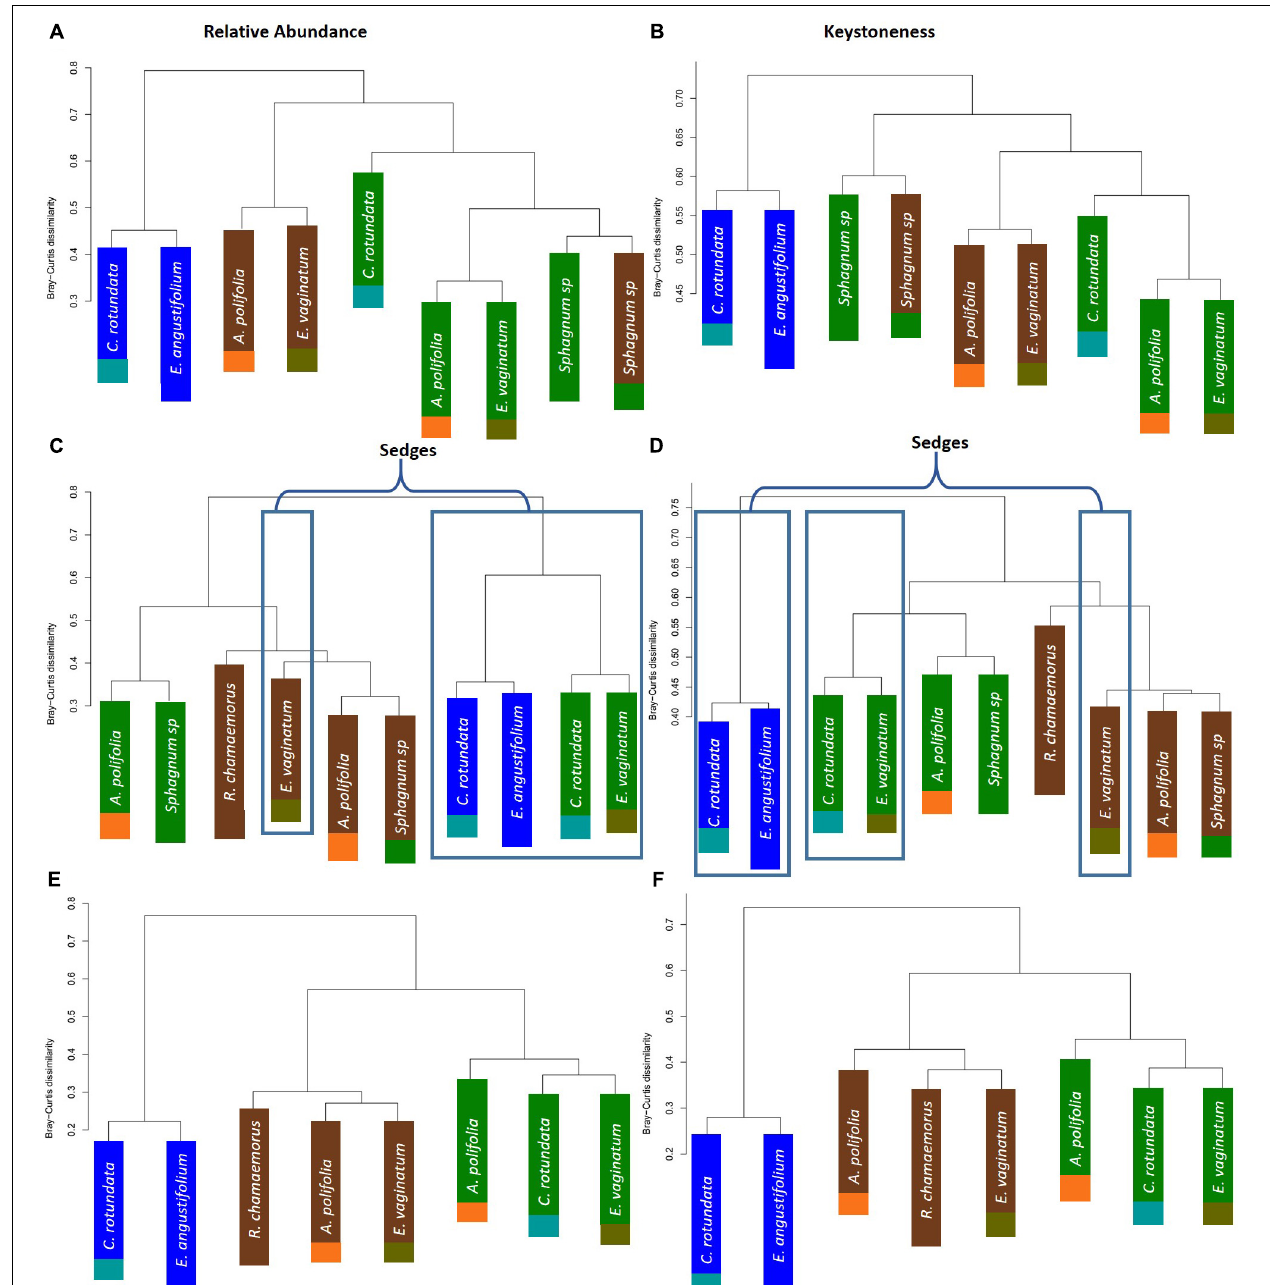
FIGURE 7 | Hierarchical clustering of Bray–Curtis dissimilarity between community networks weighting organisms by (A,C,E) relative abundance for a given habitat/plant and (B,D,F) relative importance for a given habitat/plant. Main colors correspond to habitat with brown = palsa, green = bog, blue = fen. Accent colors represent plant species with orange = A. polifolia , brown = R. chamaemorus , olive = E. vaginatum , dark green = Sphagnum , teal = C. rotundata , dark blue = E. angustifolium